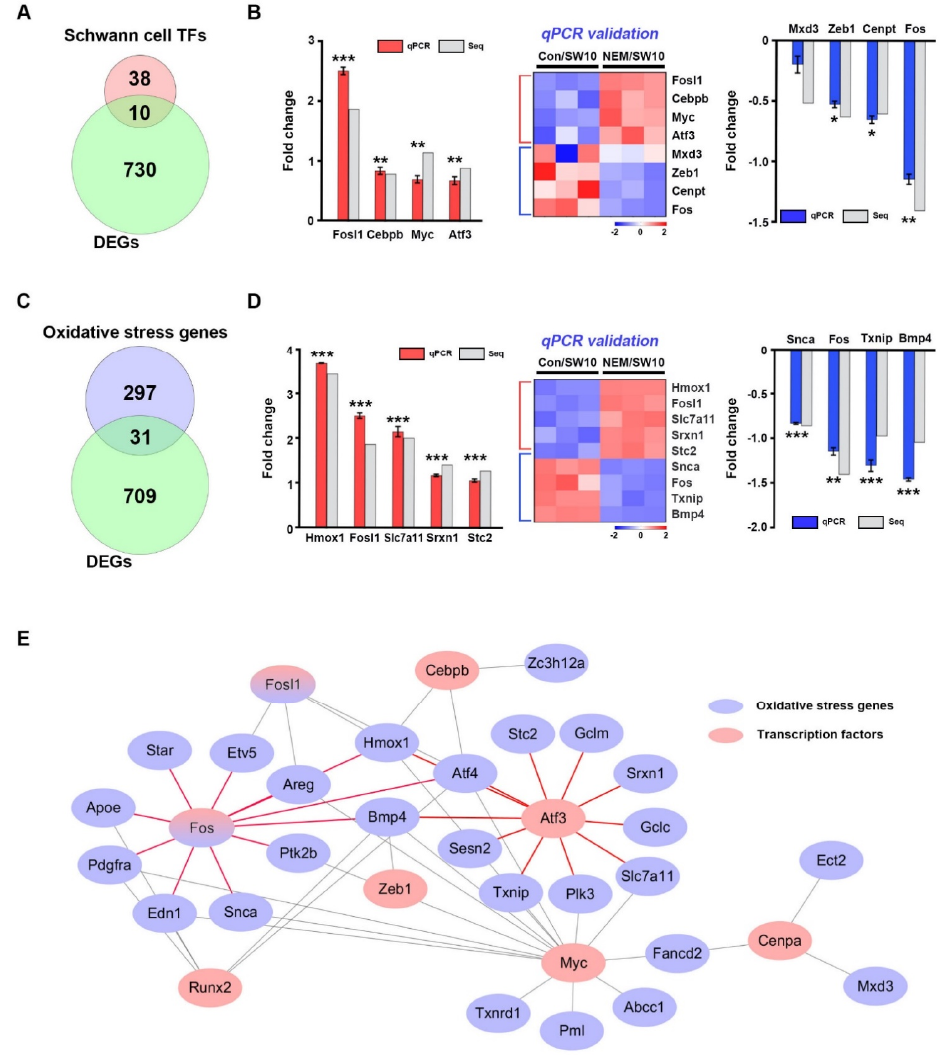
Figure 2. Interaction between oxidative stress genes and transcription factors at the transcriptomic level. ( A ) Venn diagram shows transcription factor (TF) genes involved in their in vivo expression among differentially expressed genes (DEGs). ( B ) Four upregulated and four downregulated tran- scription factor genes were validated by qPCR. Heatmap shows the relative expression levels of genes. Seq, RNA sequencing. ( C ) Venn diagram shows oxidative stress genes among differentially expressed genes (DEGs). ( D ) Validation of the expression of nine oxidative stress genes by qPCR showed increased expression of five genes and decreased expression of four genes. Heatmap shows the relative expression levels of genes. ( E ) Interconnection network between oxidative stress and transcription factor genes. The red and purple colors denote transcription factors and oxidative stress genes, respectively. Comparisons were performed using a Student’s t -test. * p < 0.05, ** p < 0.01 and *** p < 0.001.